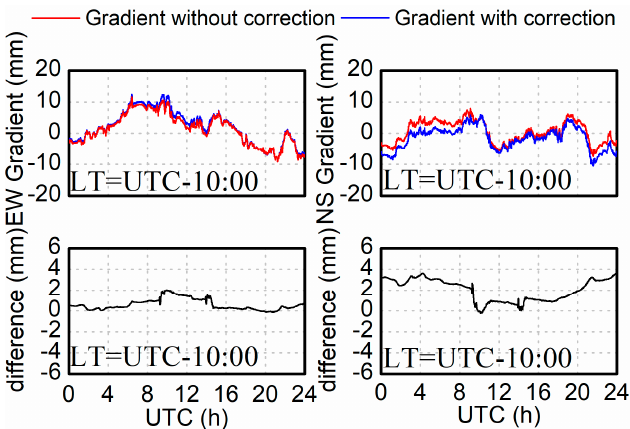
Figure 12. The estimated tropospheric horizontal gradients ( top ) with and without HOI corrections and their differences ( bottom ) on station MAUI during the active period.